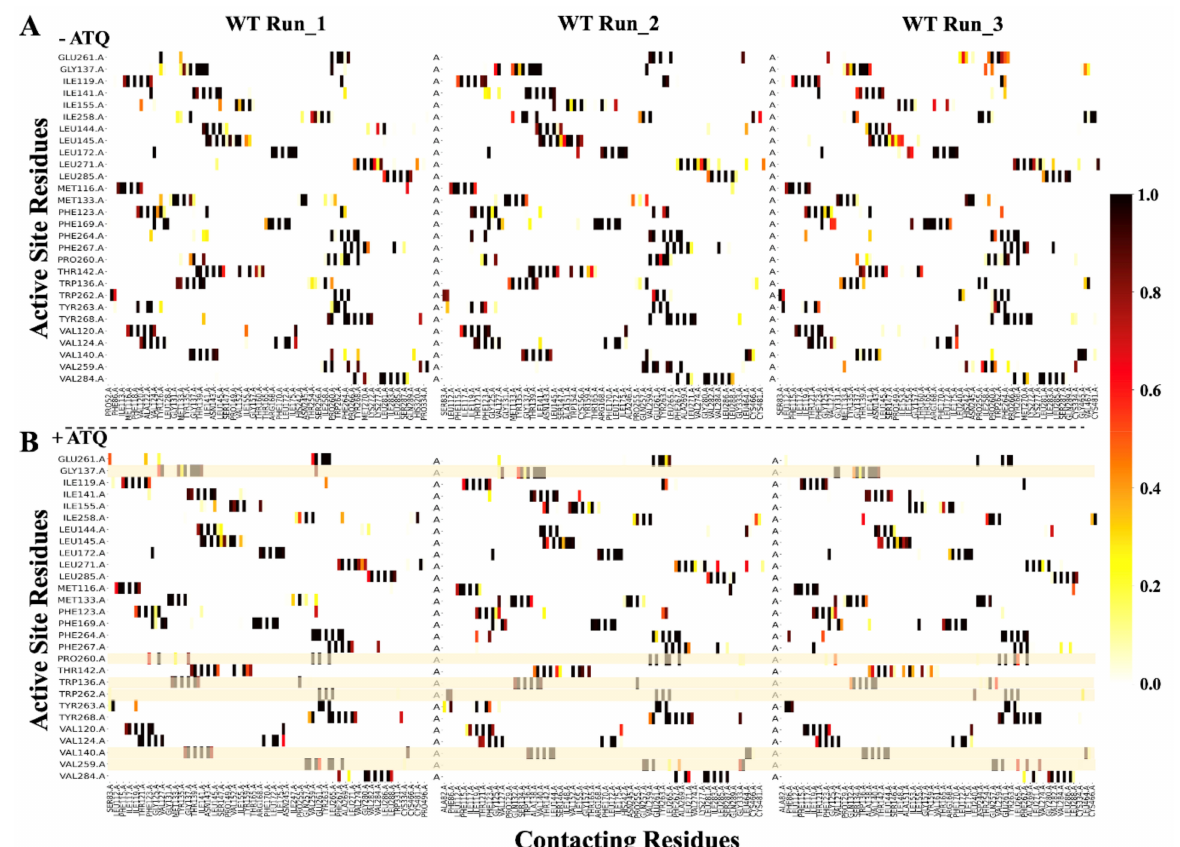
Figure 8. Residue contact heat maps for PfCytb-ISP active site residues. Heat map representations of the active site residues forming contacts with other residues (contacting residues) in ( A ) WT (wild-type) system across triplicate runs in holo protein structure and ( B ) WT system across triplicate runs in ATQ-bound protein structure. The residue contacts were monitored over during the last 100 ns of the simulation time. The yellow lines across the heatmaps in ( B ) highlight residues of either reduced or lost contacts relative to the WT. Color intensity is proportional to the occurrence of residues contact throughout the simulation, i.e., 0–1 on the color bar is equivalent to 0–100% MD simulation time. Zoomed figures comparing each of the mutant systems to WT in both holo and ATQ-bound forms are shown in Figures